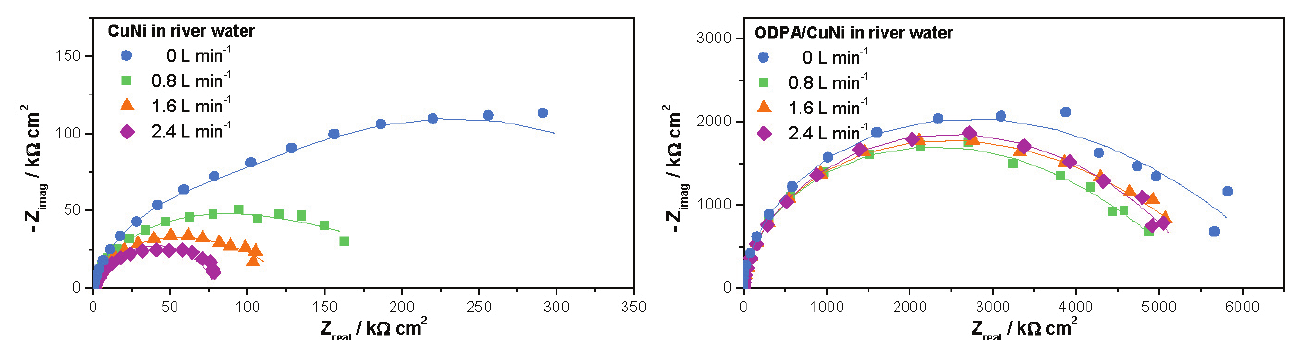
Fig. 3 – Nyquist plots of EIS spectra for blank and ODPA-treated CuNi alloy at different river water flow rates. Dots represent experimental data, and lines represent the fitted data obtained by fitting the spectra to models given in Fig. 4.